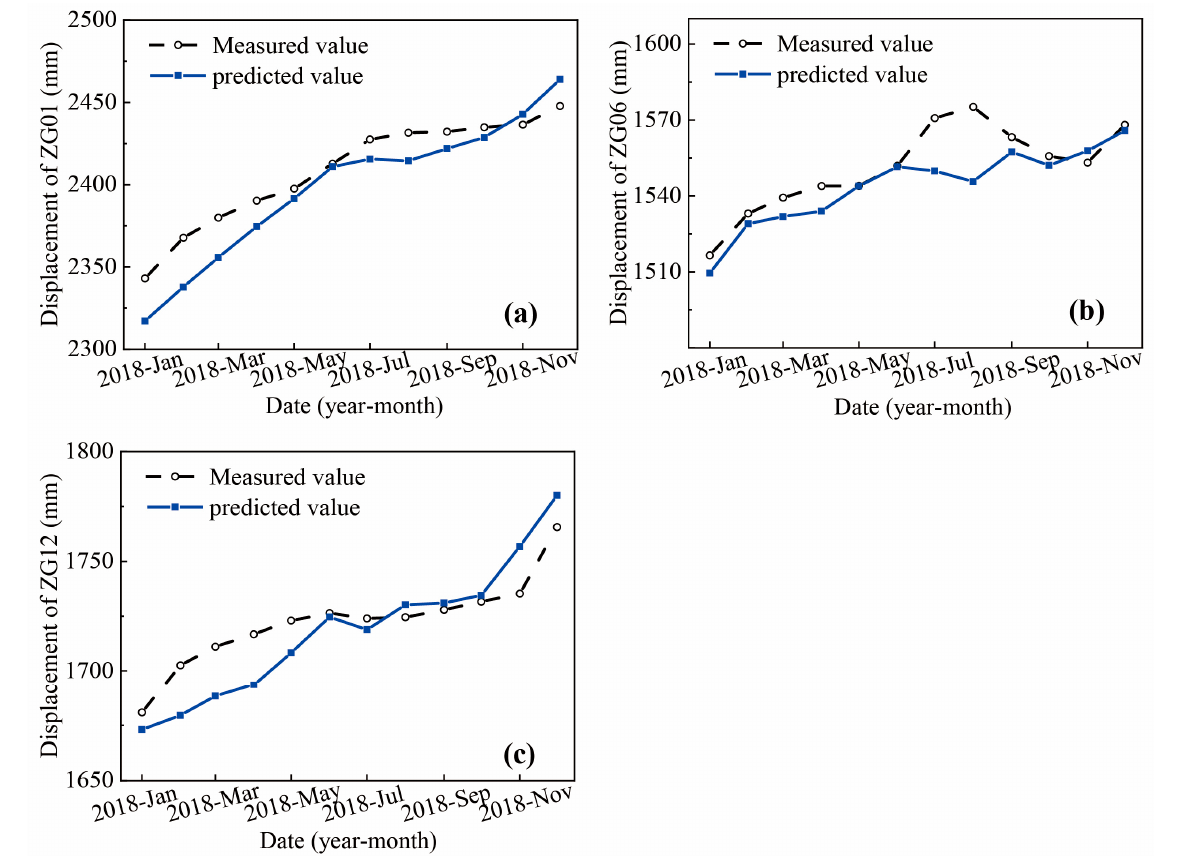
Figure 10. The predicted and measured cumulative displacements at ( a ) ZG01, ( b ) ZG06, and ( c ) ZG12.